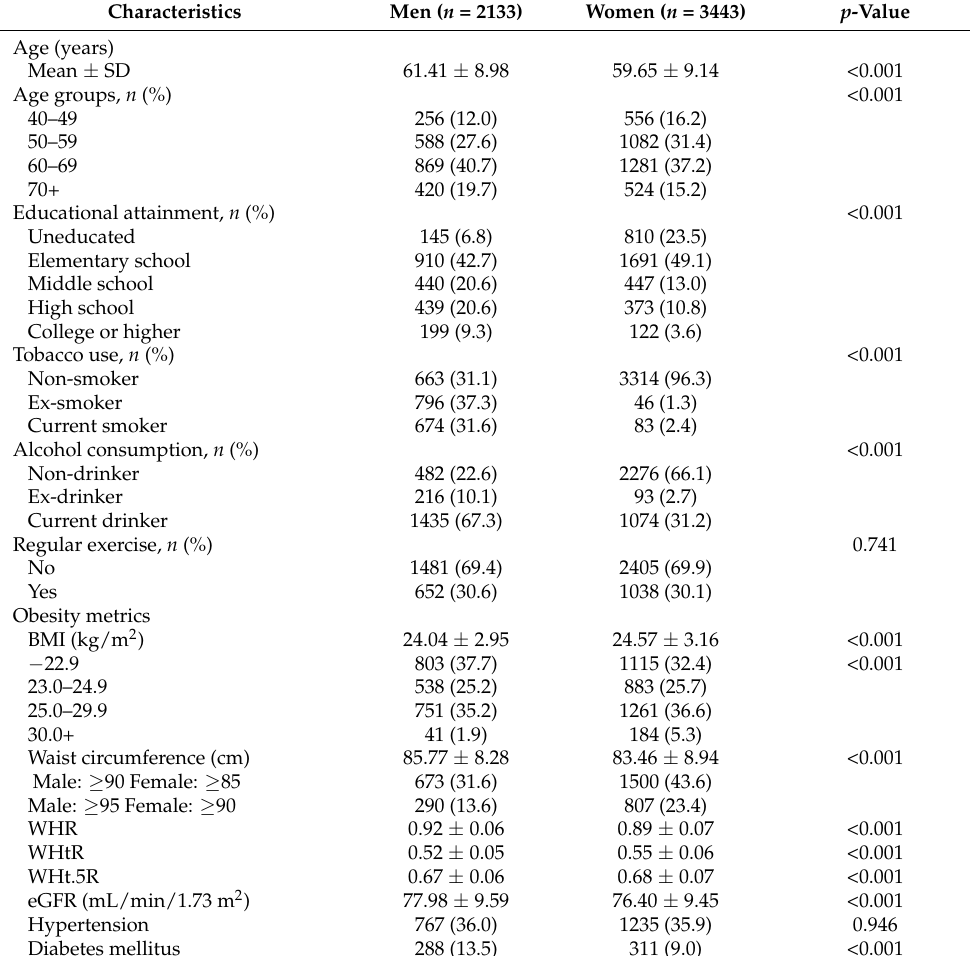
Figure 1. Flow diagram of the study population. Table 1. General characteristics of the study populations by sex.